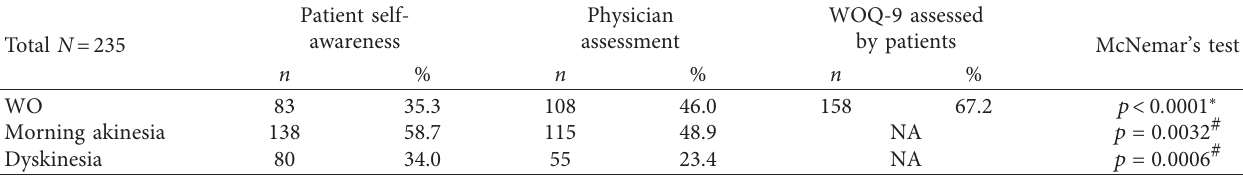
Table 3: Differences in the perception of WO, morning akinesia, and dyskinesia between patients and their physicians. Total N � 235